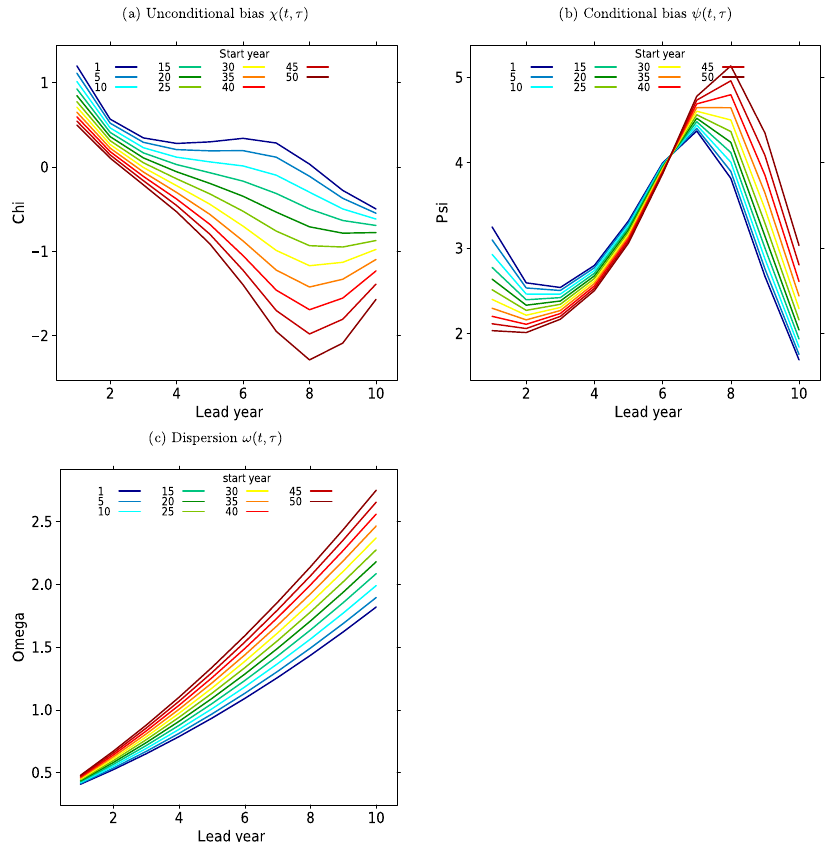
Figure 1. Unconditional bias ( a , χ(t,τ) ), conditional bias ( b , ψ(t,τ) ) and dispersion of the ensemble spread ( c , ω(t,τ) ) as a function of lead year τ with respect to different start years t